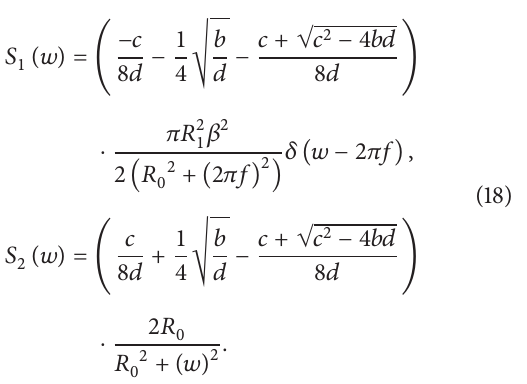
Figure 2: SNR versus noise intensity 𝐷 with 𝑏 = 0.52 , 𝑐 = −0.31 , and 𝑑 = 0.04